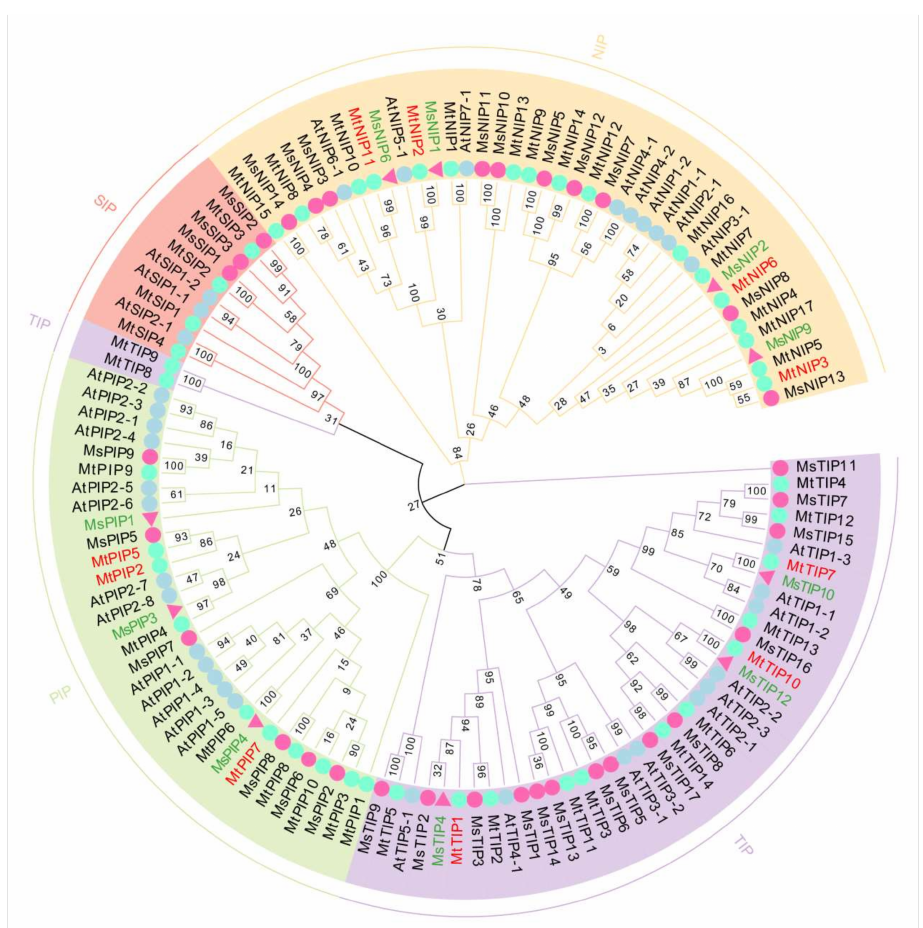
Figure 1. The phylogenetic analysis of AQP proteins from M. sativa , M. truncatula and Arabidopsis . The deduced full-length protein sequences of AQPs were constructed by using MEGA7 software based on the Maximum likelihood (ML) method, with bootstrap value of 1000 replicates. Members of four subfamilies of TIPs, PIPs, NIPs and SIPs are highlighted with purple, green, yellow and red backgrounds, respectively. The pink circles indicate AQP proteins from M. sativa; the cyan circles indicate AQP proteins from M. truncatula; and the light-blue circles indicate AQP proteins from Arabidopsis . The AQP proteins from M. truncatula are highlighted in red; while those from M. sativa are highlighted in